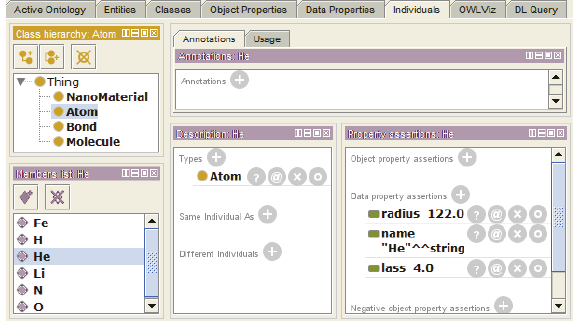
Figure 3: OWL file for saving atom properties.